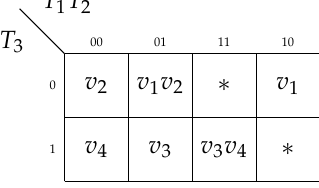
Figure 7. Multi-functional map of